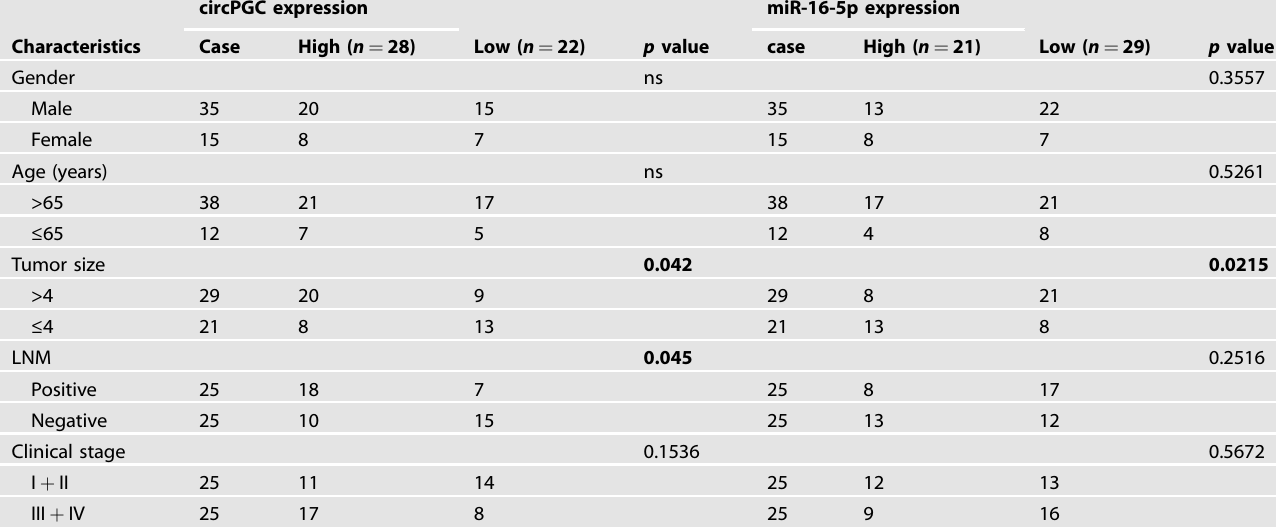
Table 1. Relation between circPGD and miR-16-5p levels and the GC clinical features. circPGC